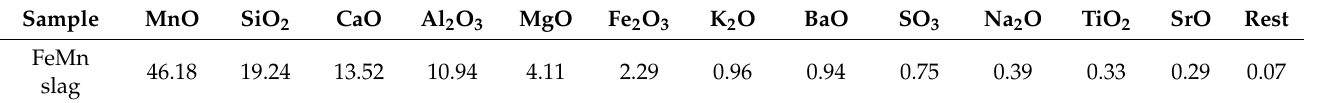
Table 2. Chemical composition of HCFeMn slag by XRF (wt.%).